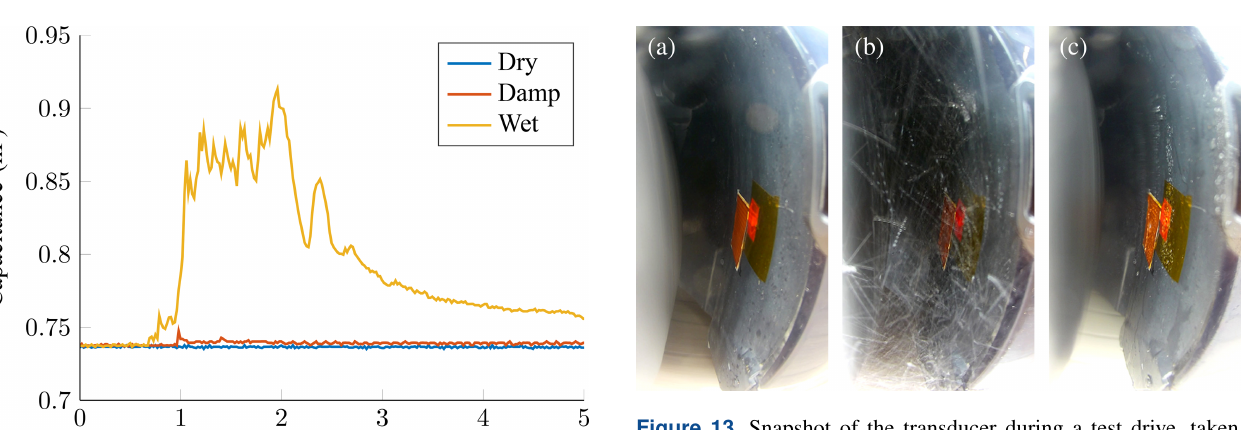
Figure 13. Snapshot of the transducer during a test drive, taken with an action camera mounted on the vehicle body for a wet test road (a) before, (b) during and (c) after the wet